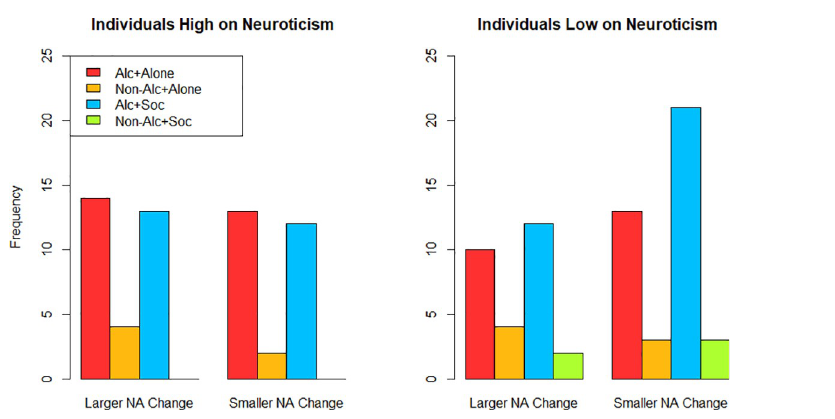
Fig 3. Bar plots investigating interaction between NA change and